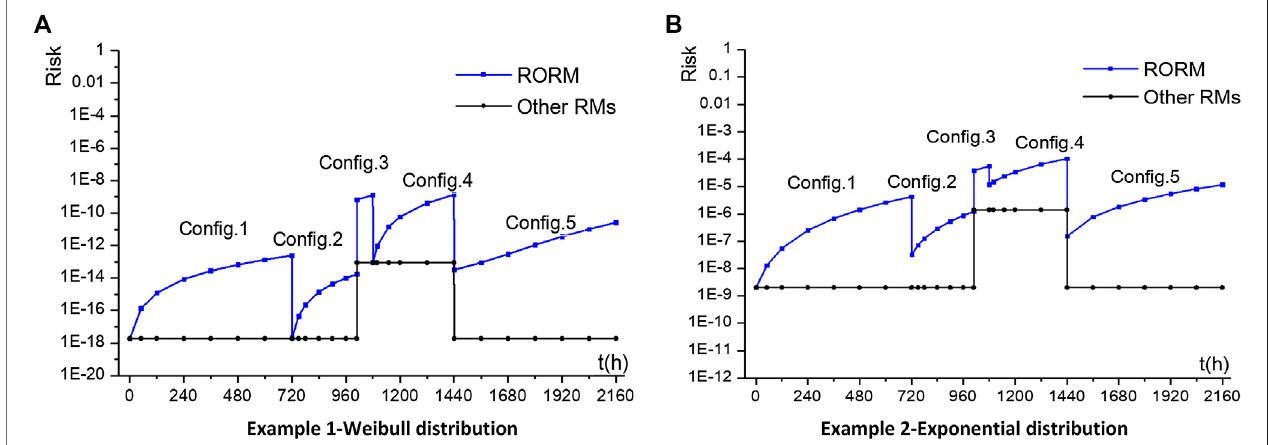
FIGURE 5 | Comparison of risk pro fi le between RORM and other RMs. (A) Example 1-Weibull distribution. (B) Example 2-Exponential distribution.